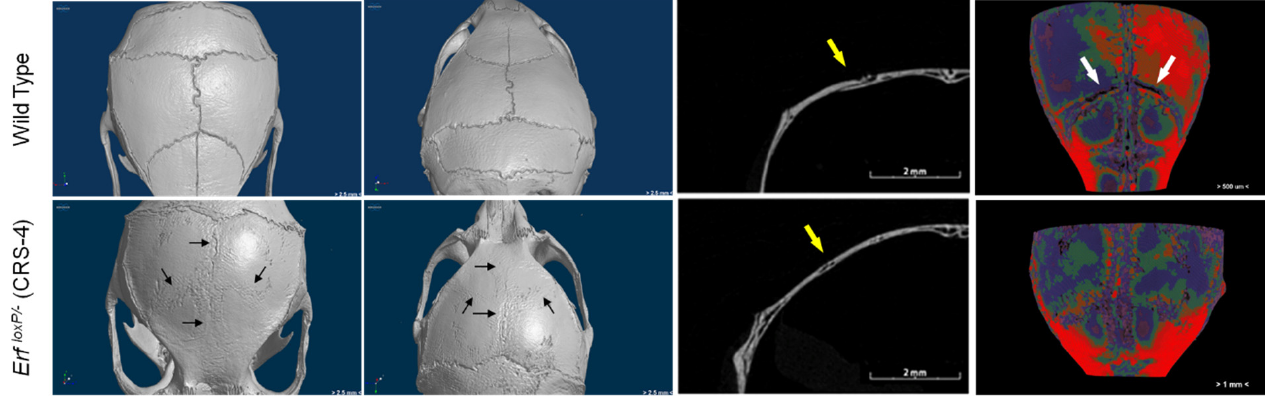
Figure 14. ( a ) Three-dimensional (3D) volume renderings, ( b ) transverse section image midway through the right coronal suture, and ( c ) bone thickness visualisation derived from microCT scans of wild-type and a Erf loxP/ − (CRS-4) animal with multisuture synostosis at P65. Black arrows indicate the fused sutures. Yellow arrows point to the coronal suture position in the transverse sections. White arrows indicate the minimal bone thickness in the coronal suture region in the wild-type animal.